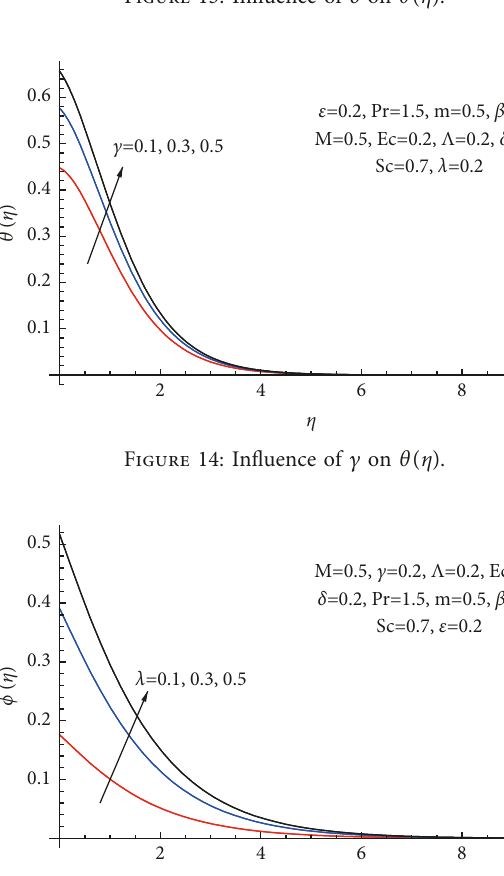
Figure 11: Influence of ε on θ ( η ) .